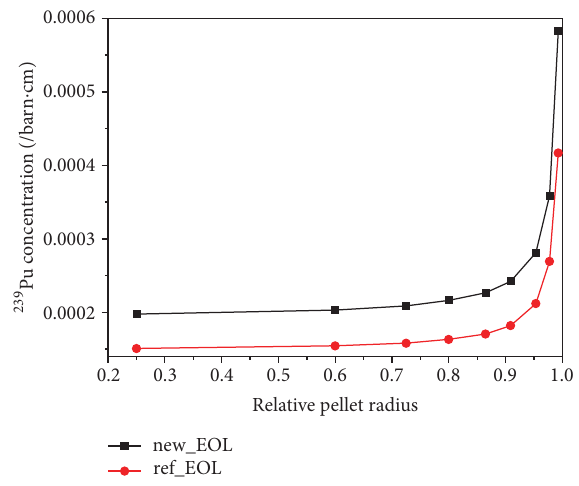
Figure 15: Radial distribution of 239